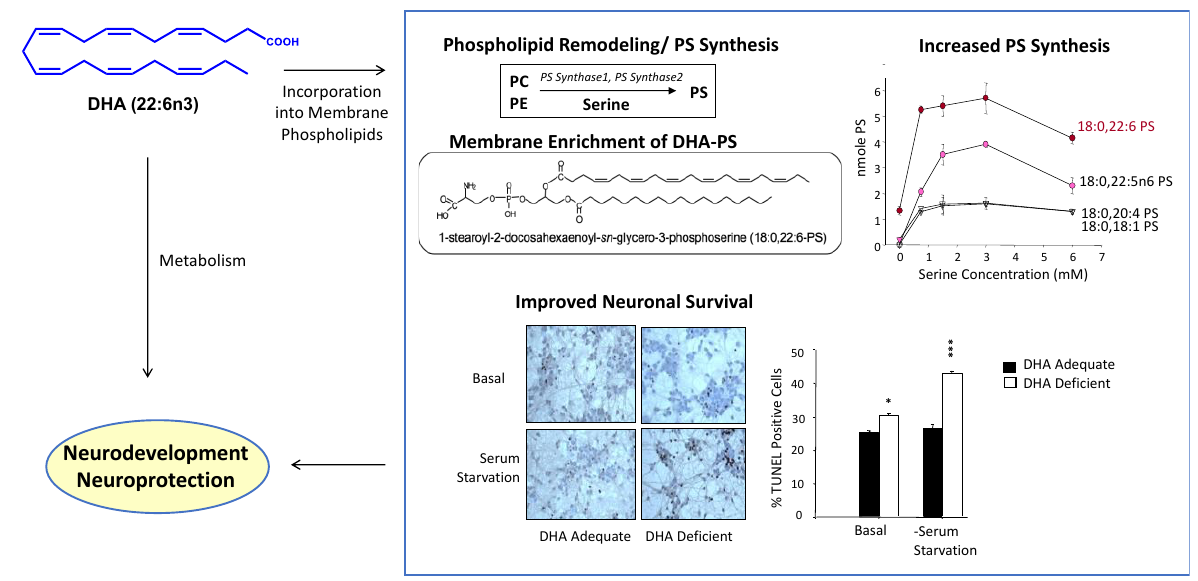
Figure 2. Neurodevelopmental and neuroprotective actions resulting from the membrane incorpo- ration and metabolism of DHA. DHA increases PS in the neuronal membrane as DHA-containing phospholipids are the best substrate for PS biosynthetic activity. Susceptibility to neuronal cell death is reduced by increasing the PS level. Certain metabolites of free DHA can also exert neuroprotective effects. DHA, docosahexaenoic acid; PC, phosphatidylcholine; PE, phosphatidylethanolamine; PS, phsphatidylserine. Adapted from references [6,17].